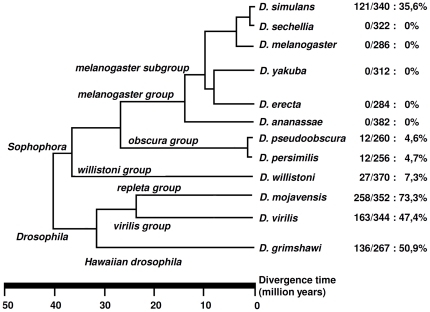
Fst PEST region size differences in Drosophila.Numbers after species names indicate, respectively, the total size (number of amino acids) of PEST regions, the size of the Fst protein, and the fraction of the protein containing PEST regions.